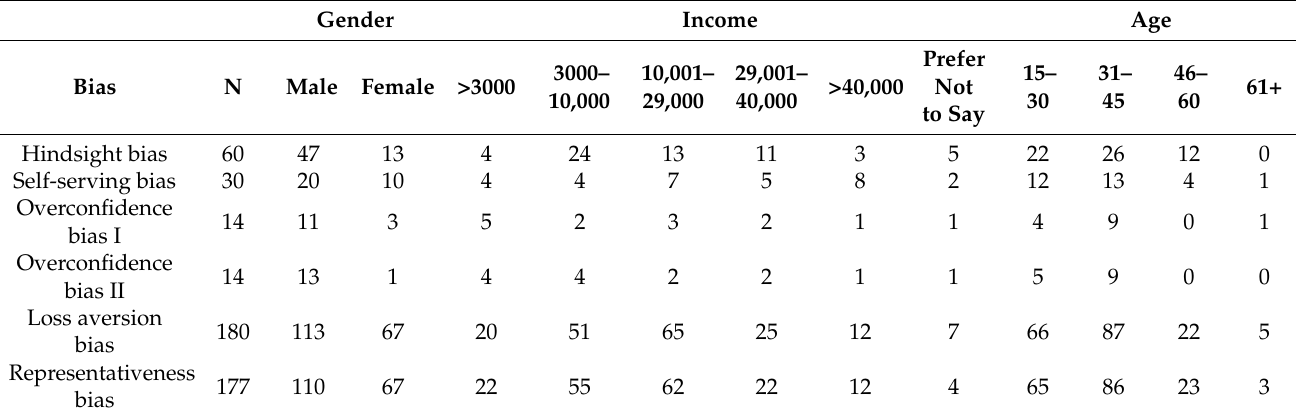
Table 1. Behavioural